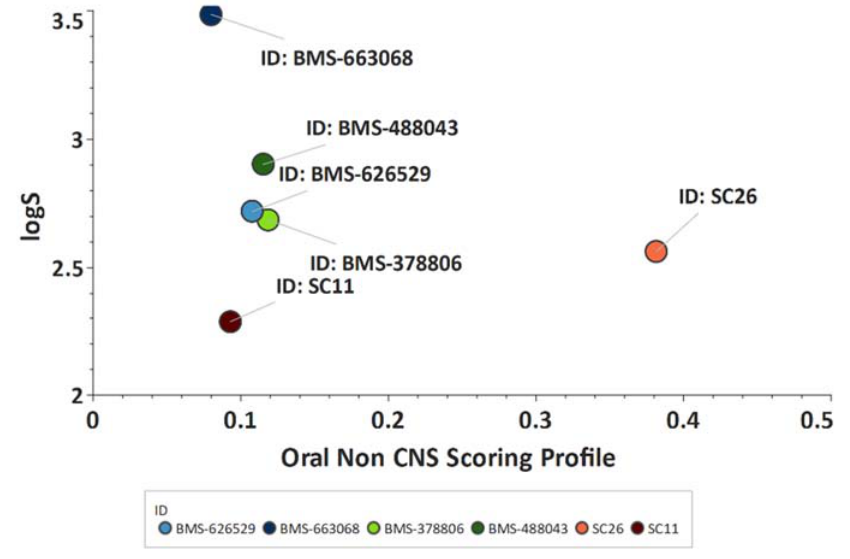
Figure 13. Improved ADME properties of SC26 . Plot showing the StarDrop (Optibrium, Ltd., Cambridge, UK)–derived logS versus the score from a multimetric oral non-CNS profile for the BMS and SC compounds. Scores range from 0 to 1, with 0 suggesting extremely non-drug-like, and 1 suggesting the perfect drug.